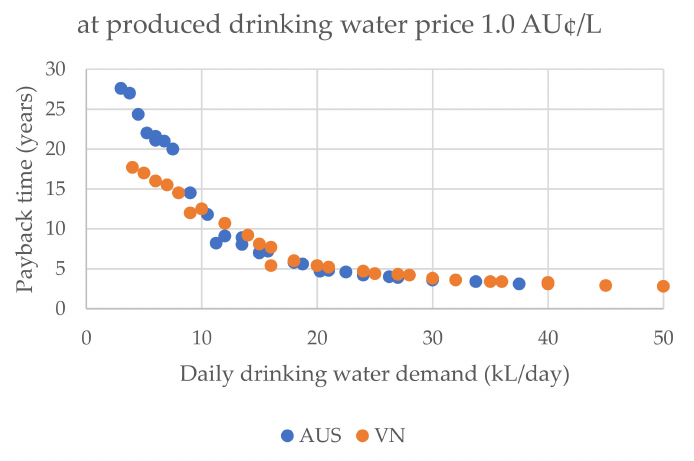
Figure 13. Payback time with respect to the produced drinking water price 0.01 AUD/L and daily drinking water demand for Australian and Vietnamese RWH